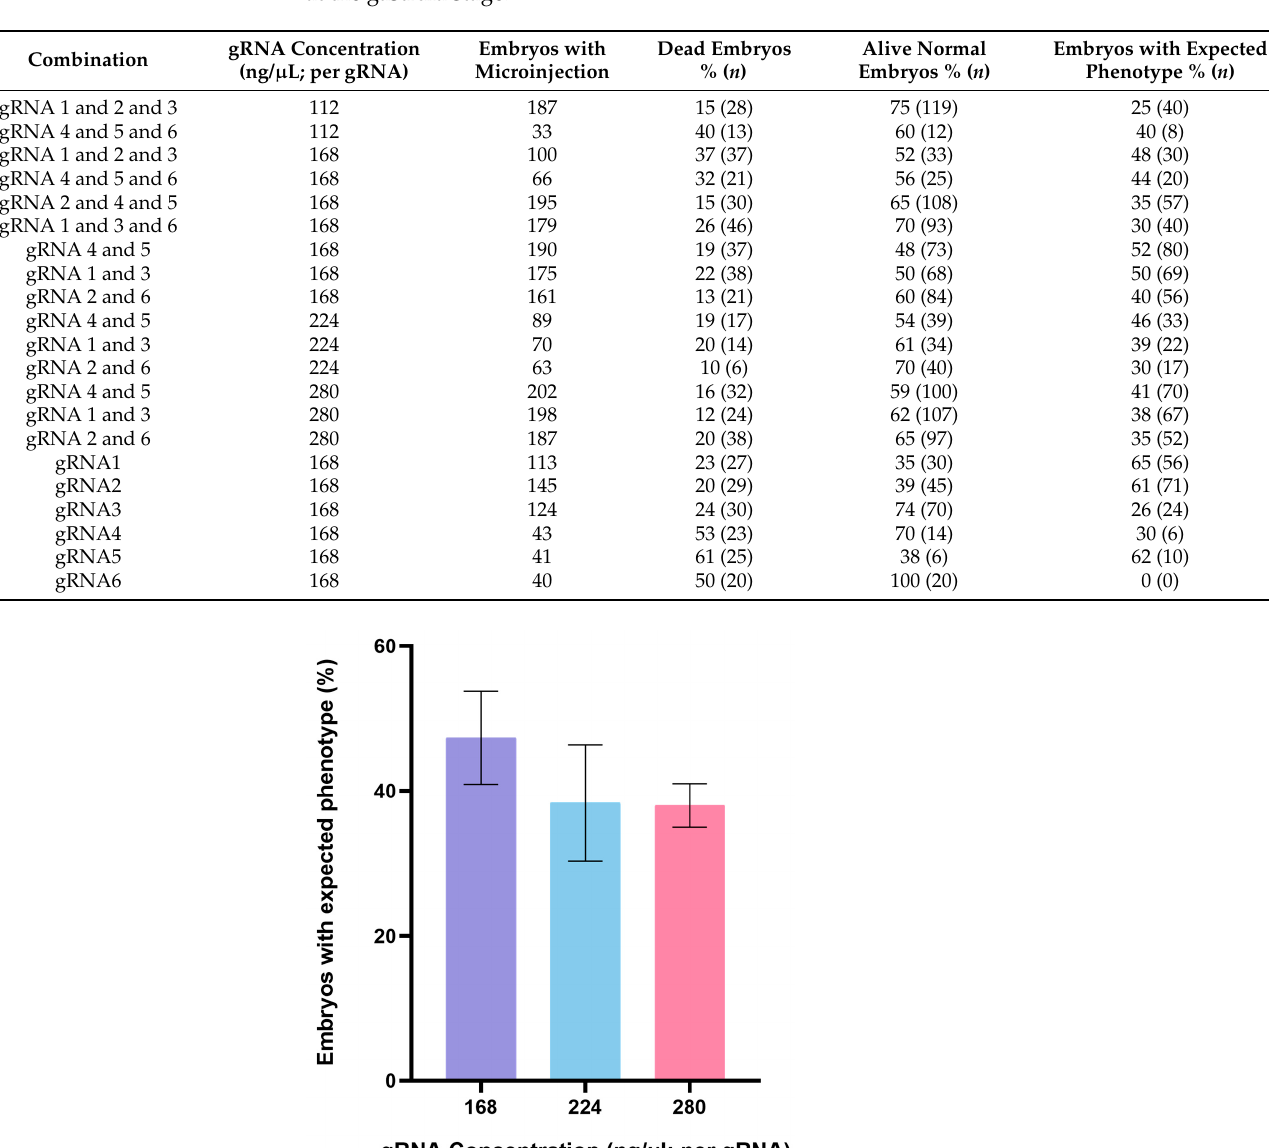
Table 2. Phenotypic ratios of embryos injected with Cas9 mRNA (258.72 ng/ µ L) and gRNAs scored at the gastrula stage.